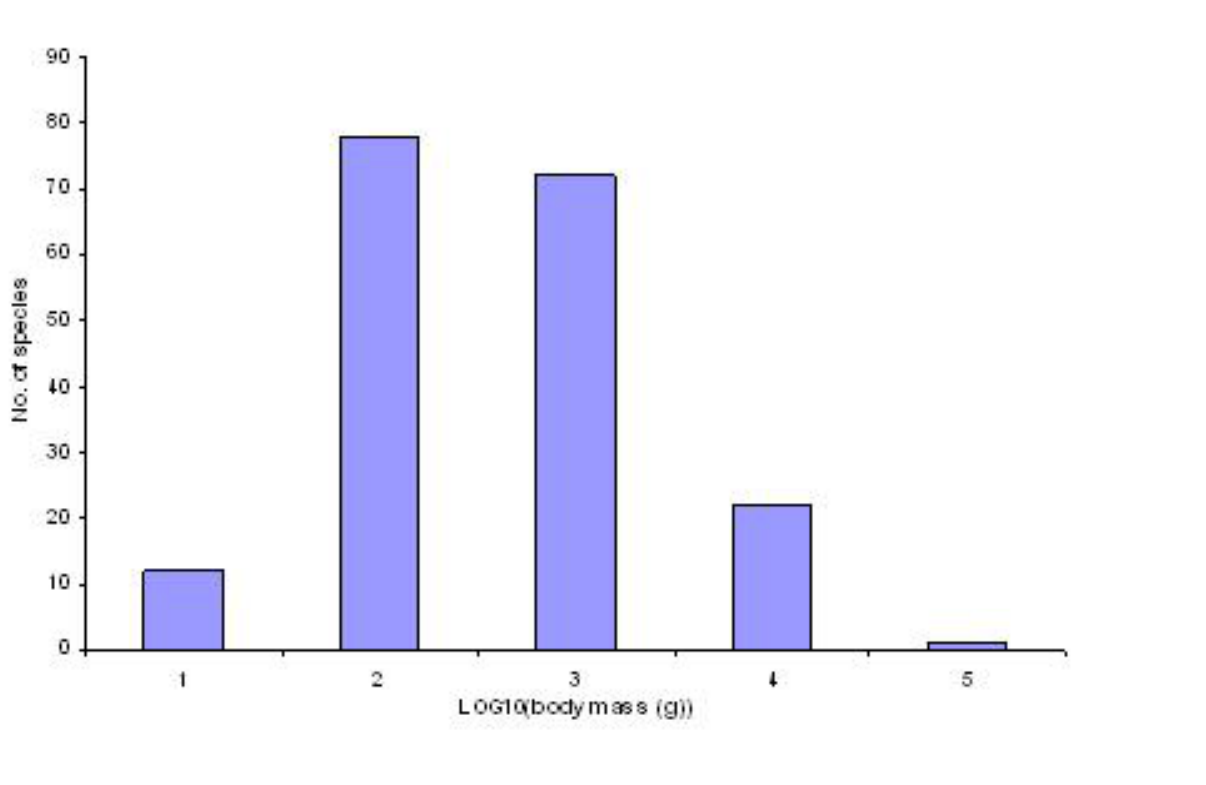
Fig. 2 . Present species distribution of 185 Danish breeding birds as a function of the log-transformed body mass. Data obtained from